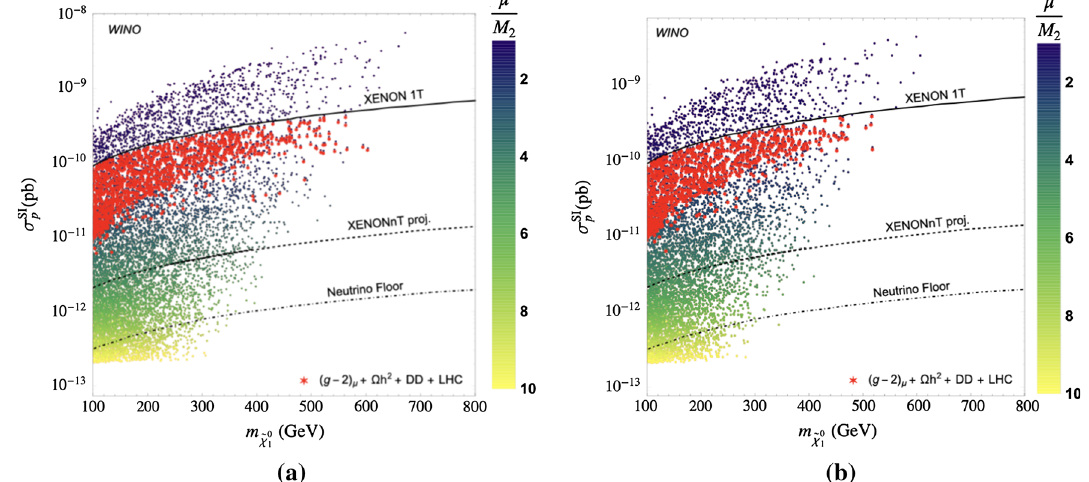
Fig. 8 Scan results in the m ˜ χ 0 - σ SI p plane for the wino DM scenario dashed and dot-dashed lines are respectively the projected reach of 1 XENON-nT and coherent neutrino scattering floor. In red we show the for current (left) and anticipated future limits (right) from ( g − 2 ) μ . points fulfilling ( g − 2 ) μ , relic density, DD and additionally the LHC The color coding of the points denotes μ/ M 2 and the black solid line indicates the current DD limit from XENON-1T while the black